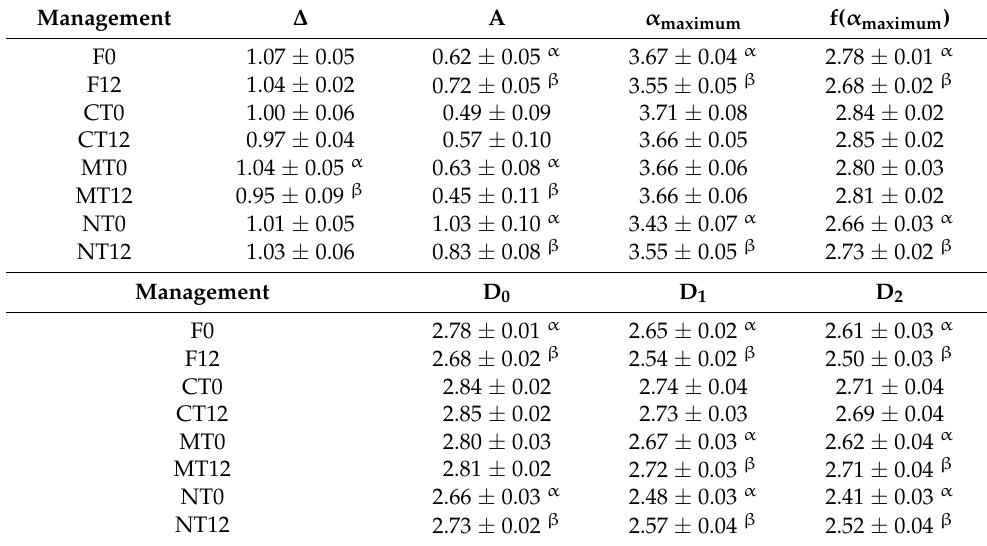
Table 2. Multifractal parameters calculated from the multifractal spectra curves (f( α ) versus α ) for the secondary forest (F) and the three management practices (conventional tillage—CT, minimum tillage—MT, and no tillage—NT) submitted to 0 and 12 wetting and drying (W-D)